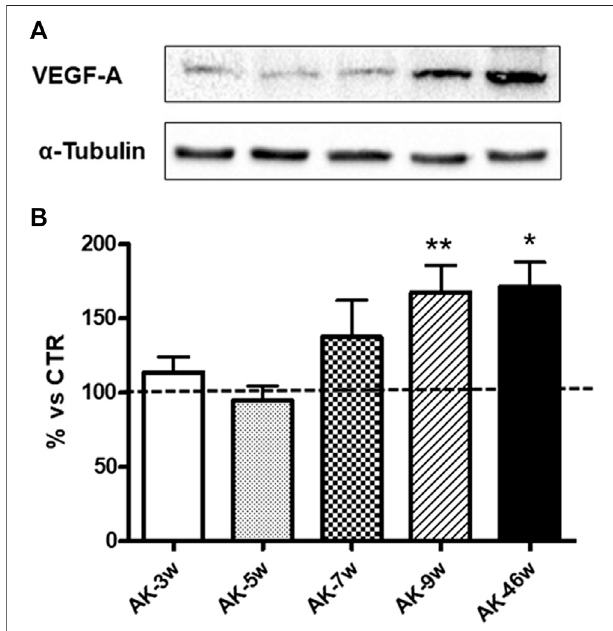
FIGURE 2 | VEGF-A protein levels in Ins2 Akita mice at different ages. (A) : Representative western blottings of VEGF-A 164 and the respective α -tubulin, measured in the same samples, of total homogenates of retinae from Ins2 Akita (AK) mice at different ages (w (cid:2) weeks). (B) : Densitometric analysis of VEGF-A 164 immunoreactivities in the total homogenates of retinae from wild- type and AK mice at different ages. Alpha-tubulin was used as a loading control. Results are expressed as % ( ± S.E.M.) vs control wild-type (100%, dashed line). * p < 0.05, ** p < 0.01 v s wild-type; Tukey ’ s Multiple Comparison post-hoc test, n (cid:2) 8 –